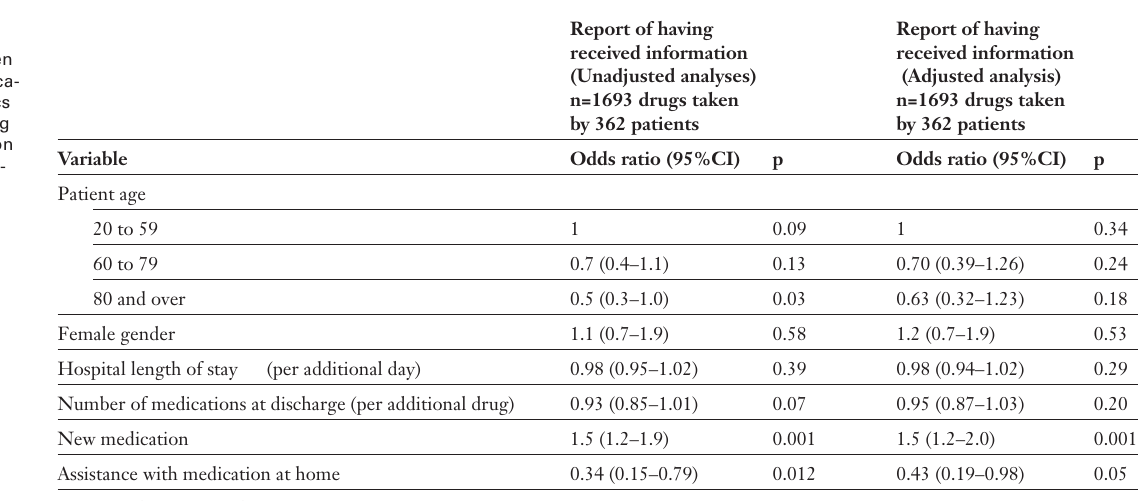
Table 3 Association between patients’ and medica- tions’ characteristics and report of having received information (unadjusted and ad- justed